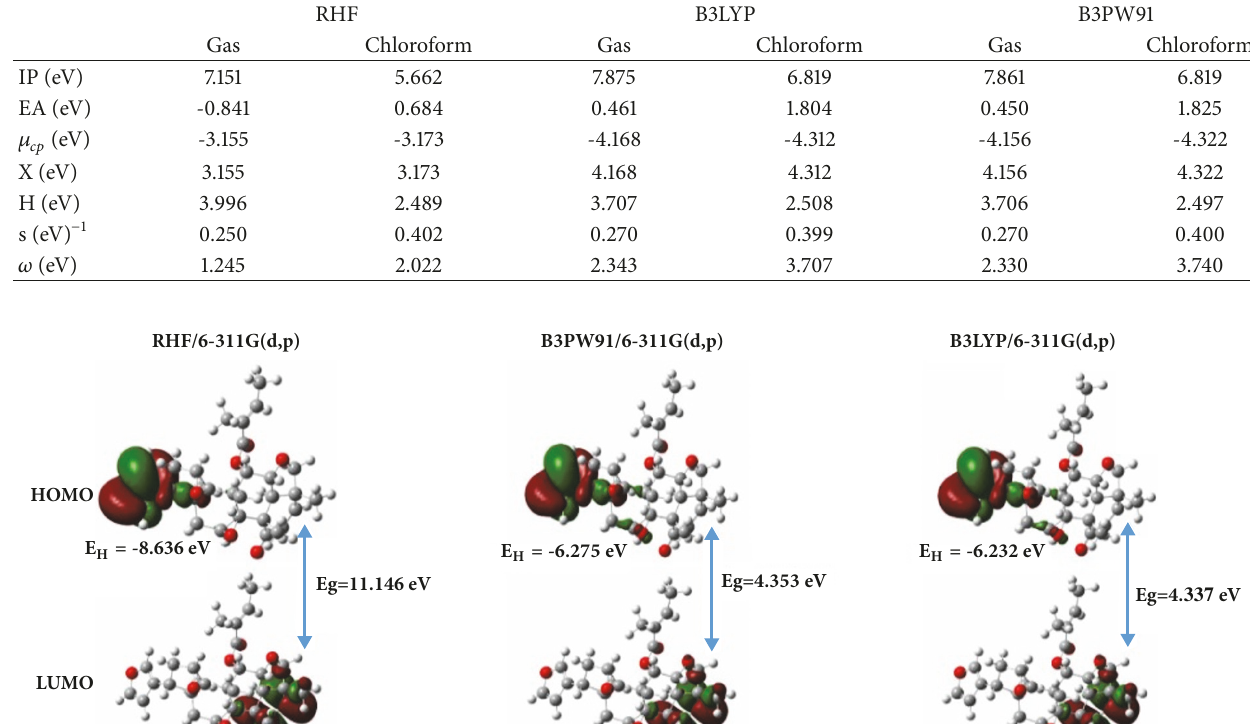
Table 3: Global reactivity descriptors of Rubescin E at the RHF, B3LYP, and B3PW91 levels in gas phase and in chloroform solution using the 6-311++G(d,p) basis set.